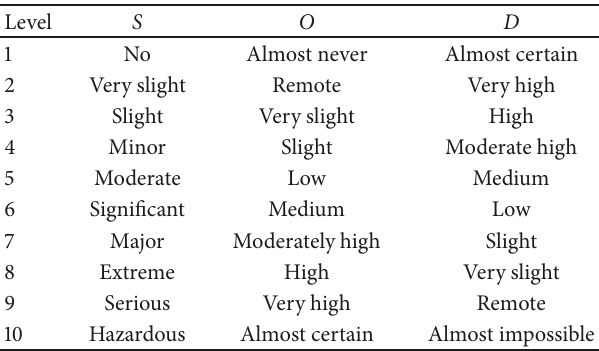
Table 1: Qualitative classification of meta-action failure mode level